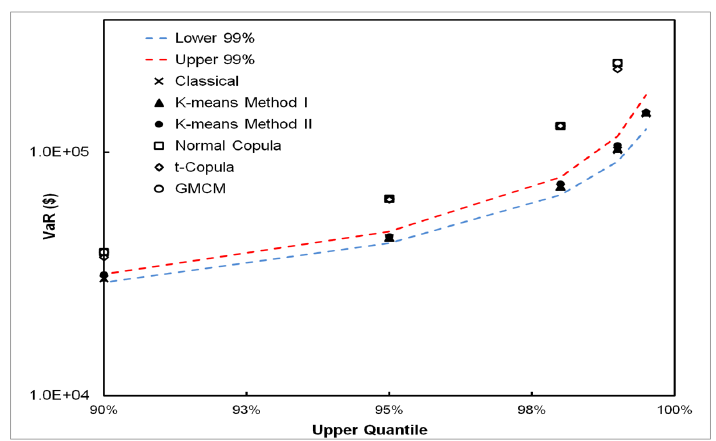
Figure 8. VaR estimates by the classical, DPFS and CPFS methods for the simulated Scenario (III); DPFS Methods (I) and (II) perform comparable to true VaR along with the classical method (since frequency is independent of severity); the copula methods overestimate the VaR in these cases. As seen from this figure, the overlapping points corresponding to the DPFS and classical methods indicate that their respective VaR estimates are within 1% of each other and thus visually indistinguishable.